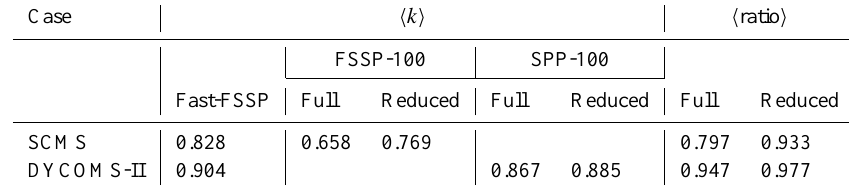
Table 3. Same as Table 2 but for the mean values over all cloudy samples of SCMS RF04 and 05 and DYCOMS-II RF07 and 08. Case h k